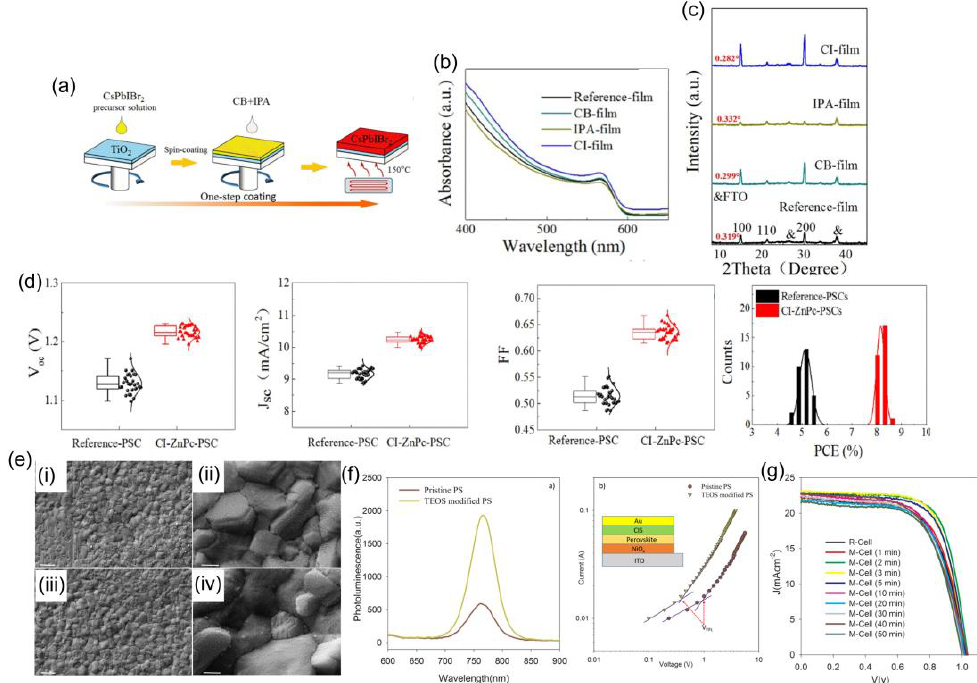
Figure 7. Antisolvent treatment. ( a ) Schematic illustration of one-step spin-coating process with modified antisolvent treatment. ( b , c ) XRD and UV – vis absorption spectra of pristine and CB-, IPA-, and CI-treated films deposited on the glass/FTO/TiO 2 substrate. ( d ) Device performance corresponding to zinc phthalocyanine (ZnPc)-modified HTL with mixed antisolvent (CB+IPA)-treated films [119]. ( e ) Top-view SEM images with pristine ( i , ii ) and TES-modified perovskite films ( iii , iv ). Scale bars are 1 µm ( i , iii ) and 200 nm ( ii , iv ). ( f ) Steady-state PL spectra of pristine Cs 0.05 (MA 0.17 FA 0.83 ) 0.95 Pb (I 0.83 Br 0.17 ) 3 PS and TEOS-modified PS films and current – voltage properties of hole-only devices with ITO/NiO x /perovskite/CIS/Au structure (inset of the figure). ( g ) J − V curve for reference and TES-modified devices with different time intervals after TES addition [118]. Reprinted with permission.